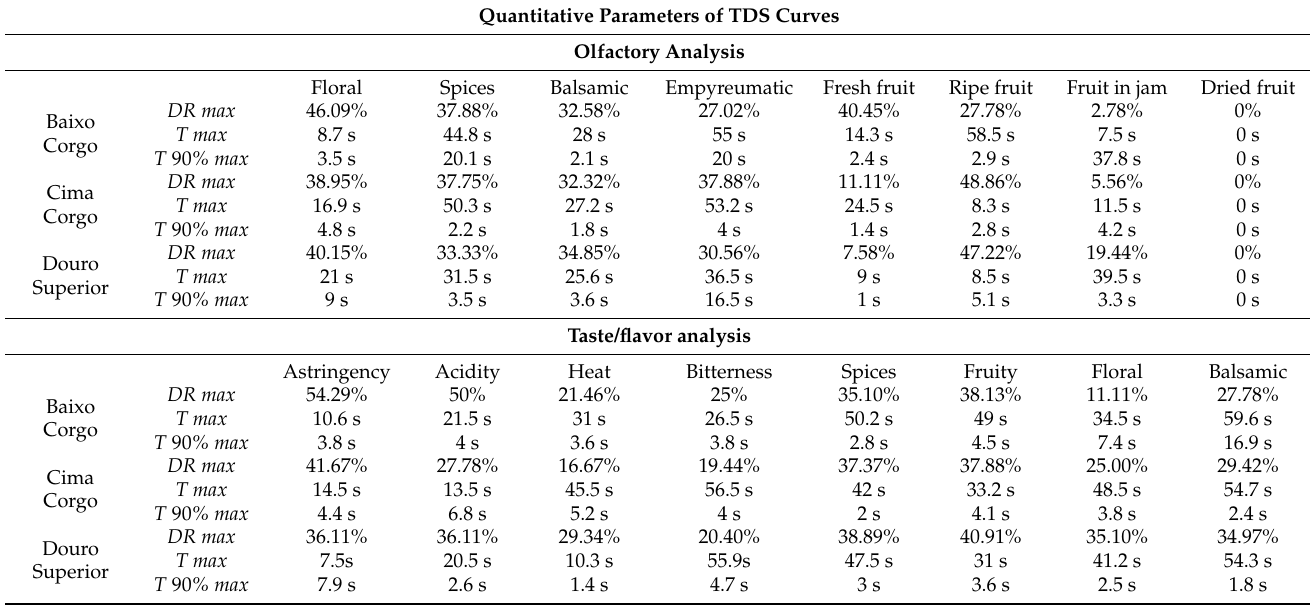
Table 8. Quantitative parameters of the TDS curves—Olfactory and taste/flavor analysis of the wines from the three sub-regions of the DDR. s—time in